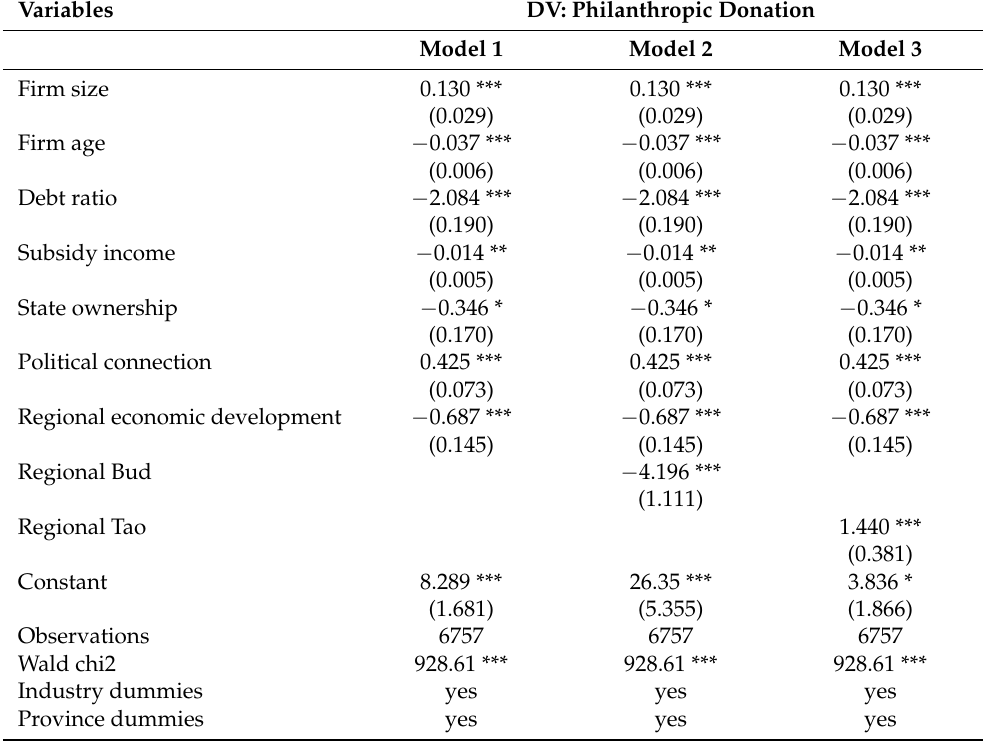
Table 4. Estimation for